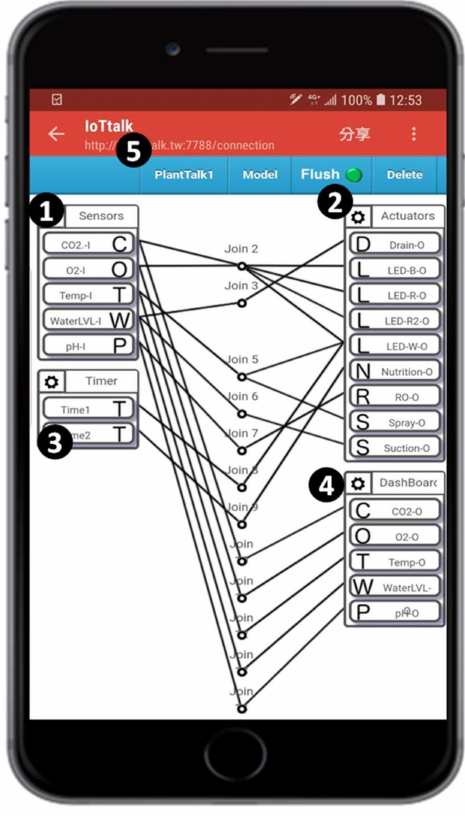
Figure 5. Project